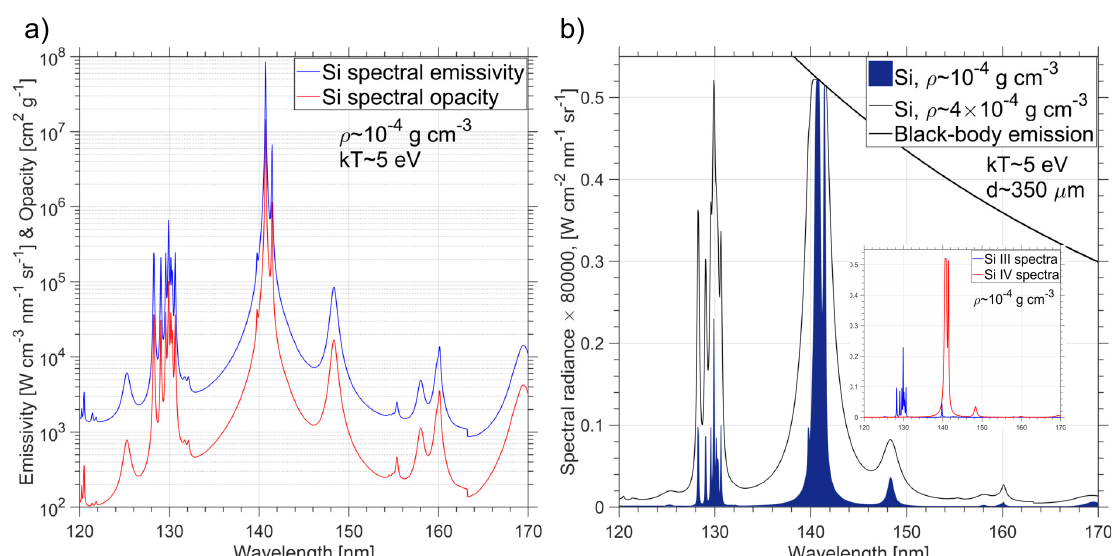
Figure 2. ( a ): Calculated spectral emissivity and opacity coefficients versus the wavelength at ρ ≈ 10 − 4 g cm − 3 and kT ≈ 5 eV; ( b ): the calculated spectral radiance for an artificial homogeneous Si plasma at ρ ≈ 10 − 4 (blue shaded area) and ≈ 4 × 10 − 4 g cm − 3 (dark solid line), kT ≈ 5 eV, and d ≈ 350 µ m. The black-body emission curve versus the wavelength at the same temperature is also shown. The spectral contributions of the main individual Si ions (i.e., Si III and Si IV) are also presented. Note that the ordinates of ( a , b ) are not in the same